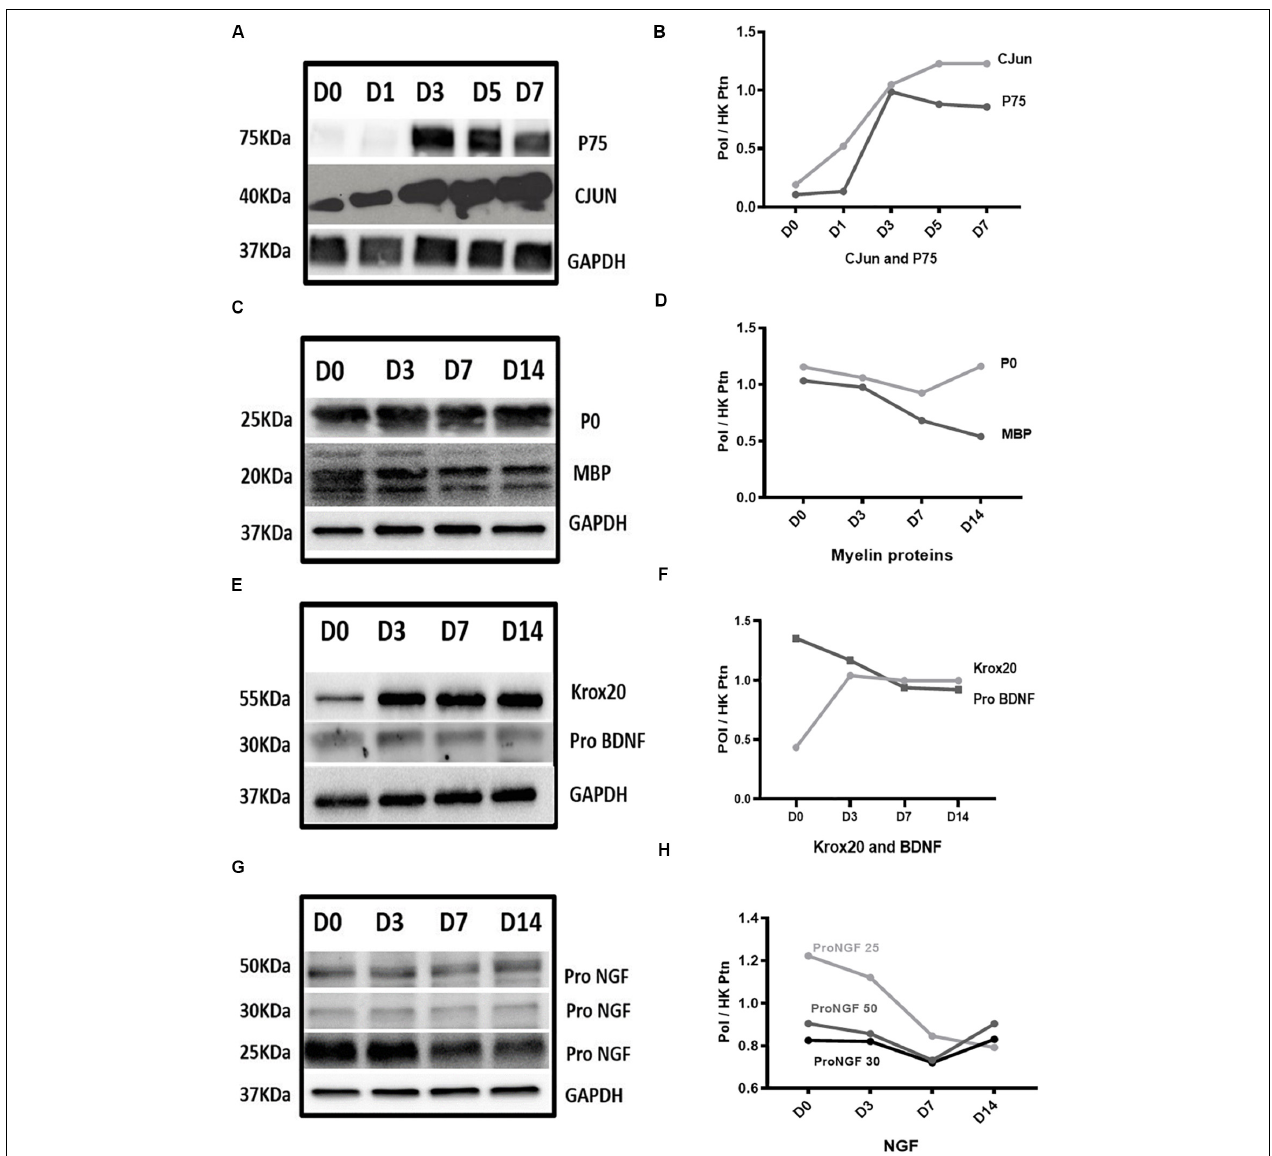
FIGURE 4 | Protein expression results in Wallerian degeneration in vitro model. (A,B) Western blot images and graph, respectively, showed persistent upregulation of CJUN and P75 proteins after WD induction. (C,D) Western blot images and graph, respectively, showed gradual downregulation of MBP protein reaching approximately 50% of its expression at D14 and P0 remained constant throughout the 14 days of in vitro WD compared to D0 healthy nerve. (E,F) Western blot images and graph, respectively, showed upregulation of KROX20 protein at D3 post-degeneration reaching a plateau which remained constant until D14 post-degeneration. PRO-BDNF protein expression showed gradual downregulation starting from D3 post-regeneration and reaching 60% of expression at D14 compared to D0 control. (G,H) Western blot graph and image of PRO-NGF, respectively, showed gradual reduction of different isoforms gradually reaching almost the same level at D14. Data is normalised by GAPDH for each time point. (PoI) is Protein of Interest. (HK ptn) is house-keeping